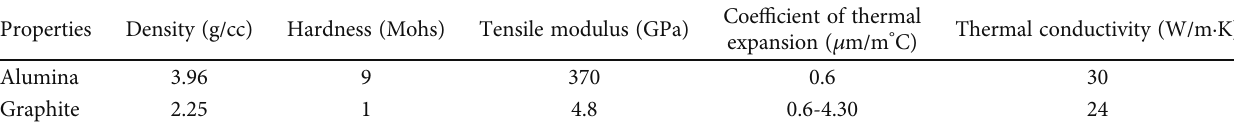
Table 2: Properties of ceramics.